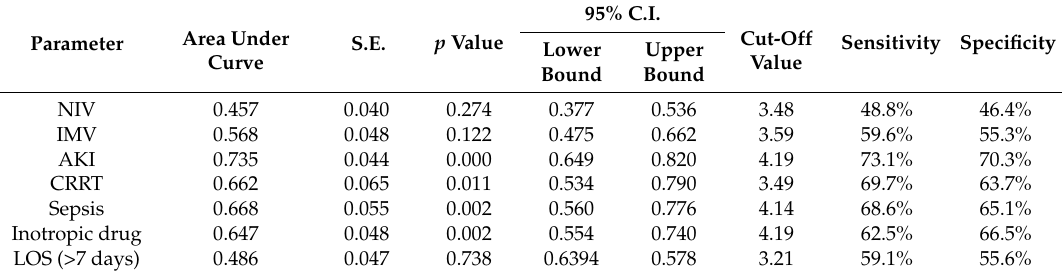
Parameter Area Under